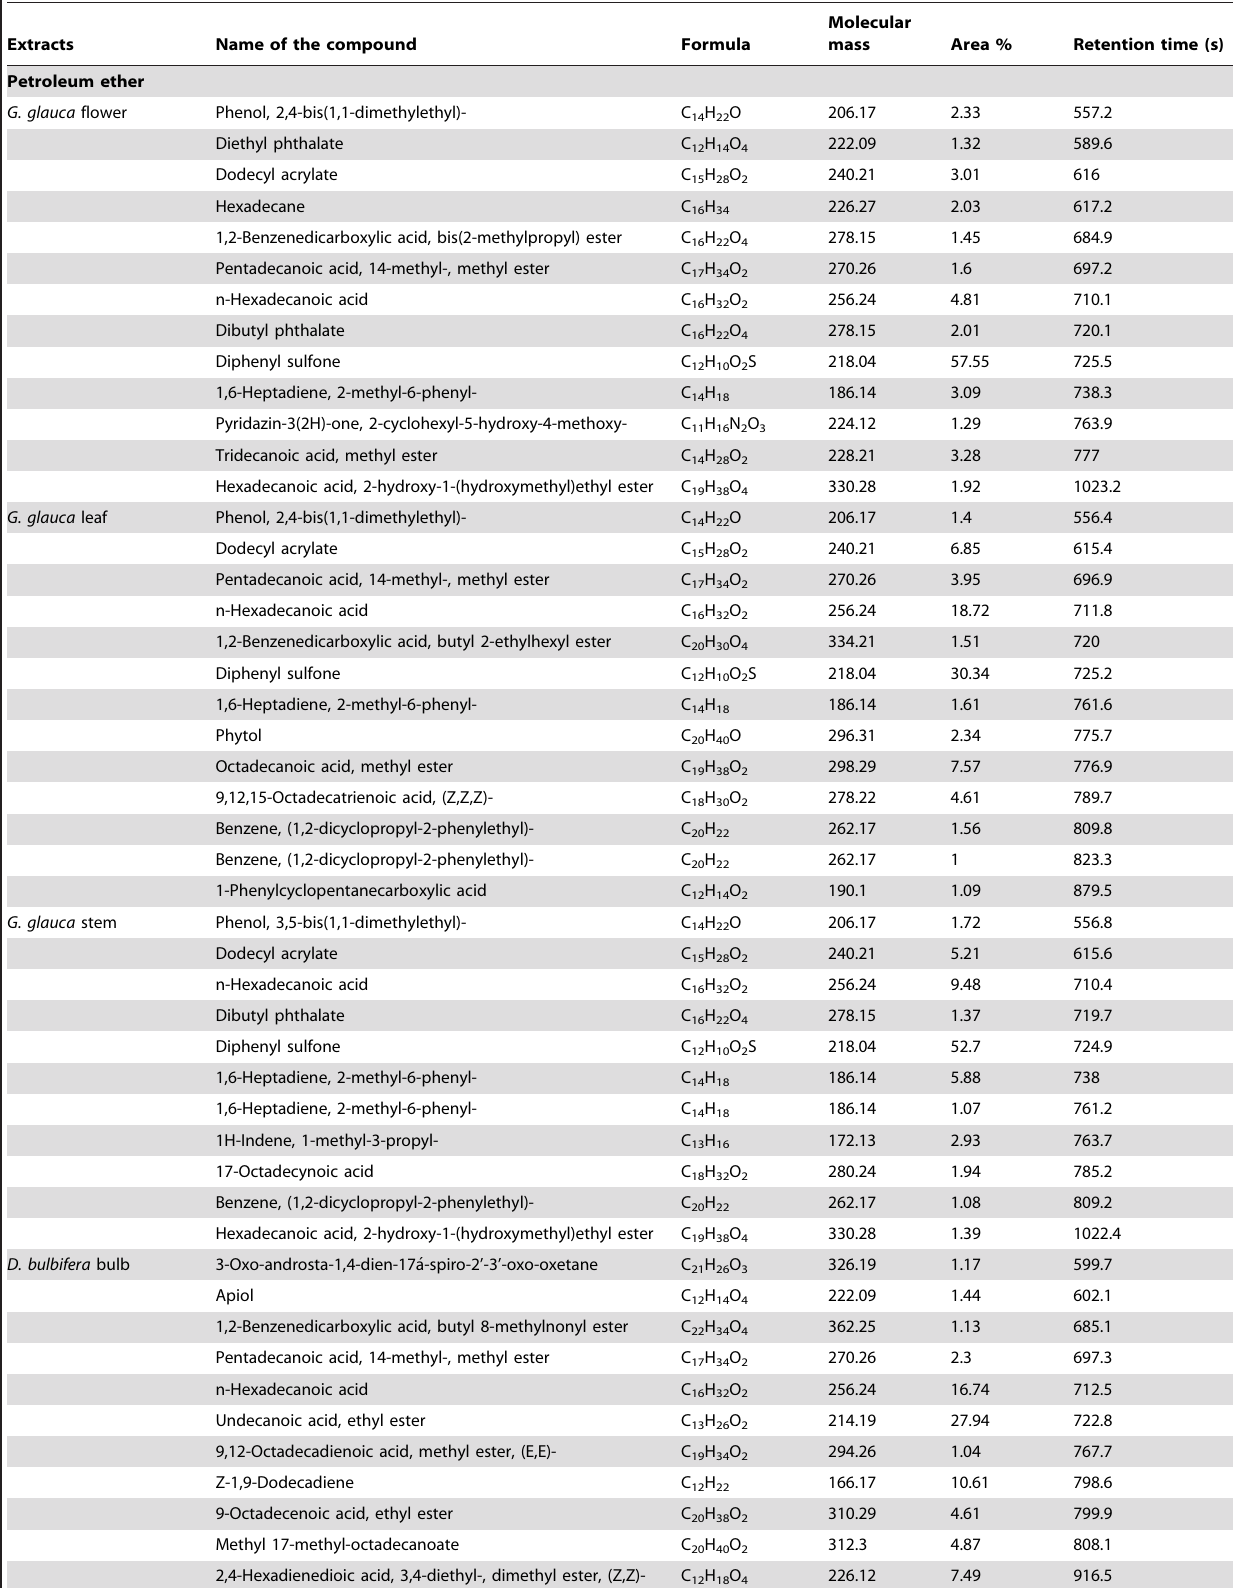
Table 8 Main compounds detected by GC-TOF-MS.